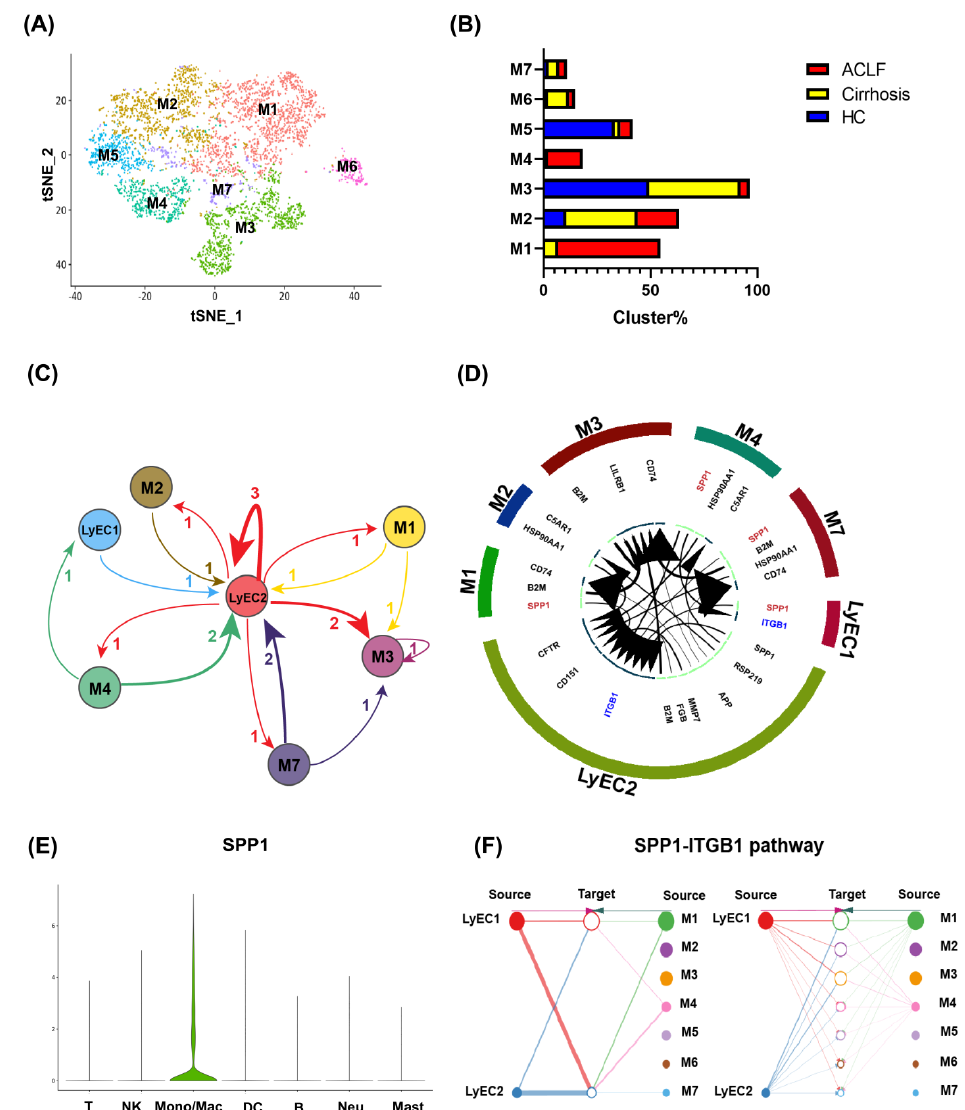
Figure 4. Infiltrating monocyte/macrophages secreted SPP1 to induce apoptosis and dysfunction of LyECs in the liver of ACLF patients . ( A ) 4738 monocyte/macrophages from HCs ( n = 2), cirrhosis patients ( n = 3), and ACLF patients ( n = 5) were divided into 7 clusters (M1-M7). ( B ) The proportion of 7 monocyte/macrophage clusters. ( C ) Receptor/ligand analyses of LyECs and monocyte/macrophages. The number on the middle arrow represents the number of highly expressed (>50%) receptors and ligands that could be paired. ( D ) The key receptor/ligand for LyECs and monocyte/macrophages. The larger the area of the arrow, the higher the expression level of the receptor/ligand on this subpopulation. ( E ) SPP1 mainly originated from intrahepatic mono- cyte/macrophages. ( F ) M1 and M4 clusters in ACLF were the main origin of SPP1. The thicker the line, the more SPP1